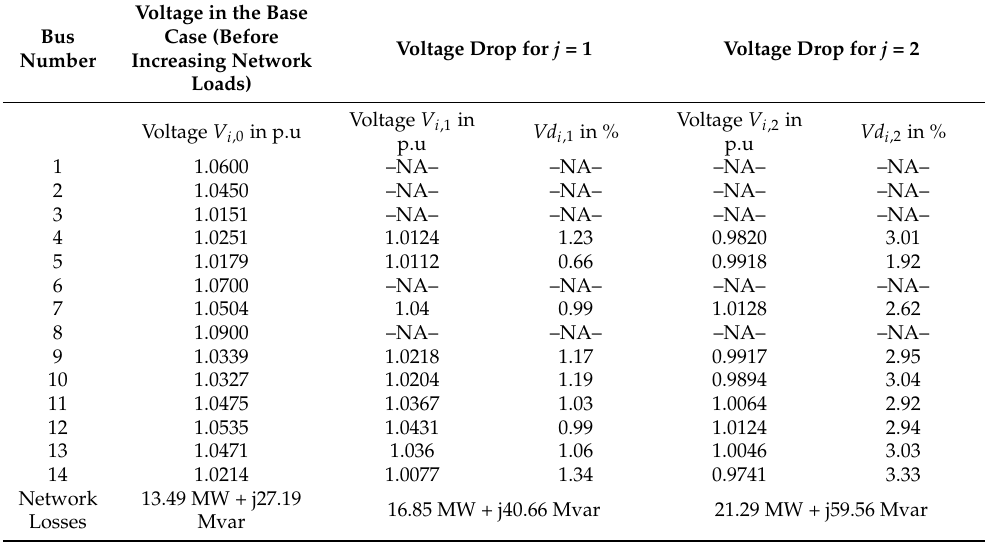
Table 1. Power flow result of IEEE 14-bus system (NA shows the buses without generator